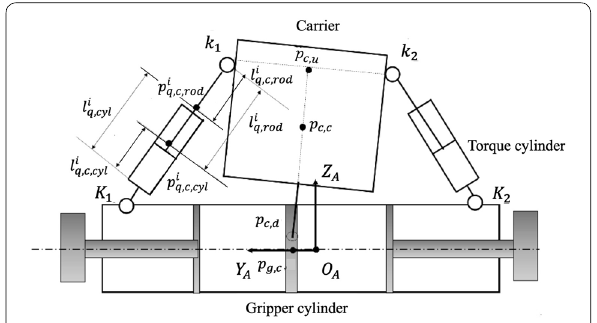
Figure 5 Mechanical structure of gripper carrier